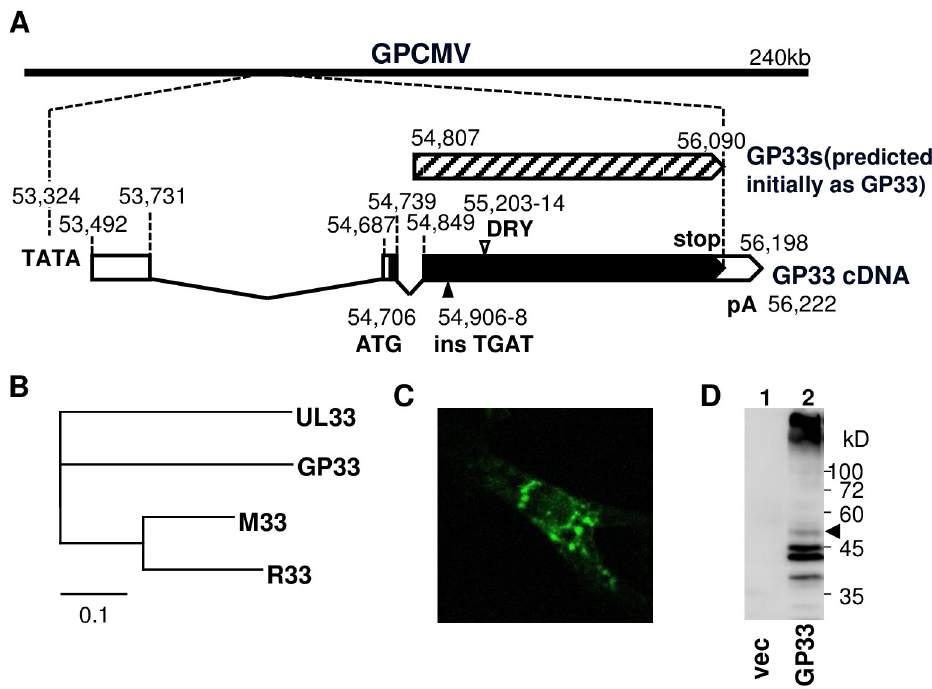
Fig 1. cDNA structure and expression of GP33. (A) The GP33 cDNA structure determined by RACE analyses is depicted with a TATA box and a poly A signal (pA). The numbers in the GPCMV genome positions are based on Kanai et al. [33]. The ORF predicted initially as GP33 (hatched box; GP33s) and the ORF determined by RACE (closed boxes; GP33) are shown. An open arrowhead indicates the location of the DRY motif. “ins TGAT” is the mutation containing a stop codon and a 1-bp insertion to generate the GP33-defective virus, Δ 33. (B) Multiple sequence alignment of GP33 homologs, HCMV UL33, MCMV M33, and RCMV R33, was performed by ClustalW analysis (DDBJ, ver. 2.1) with the default parameters except for GAP OPEN 100, and the obtained bootstrapped tree is depicted by TreeViewX software. (C) Localization of GP33-EGFP fusion protein in COS-7 cells transiently transfected with pEGFP-GP33. (D) Lysates of cells transfected with pcDNA3 empty vector (lane 1) or pcDNA-GP33F (lane 2) were separated on SDS-10% polyacrylamide gel. Proteins in the gel were transferred to polyvinylidene difluoride membrane (Millipore), and reacted with monoclonal anti-FLAG tag antibody followed by peroxidase-conjugated anti-mouse IgG. An arrowhead indicates the expected full-length GP33 band.